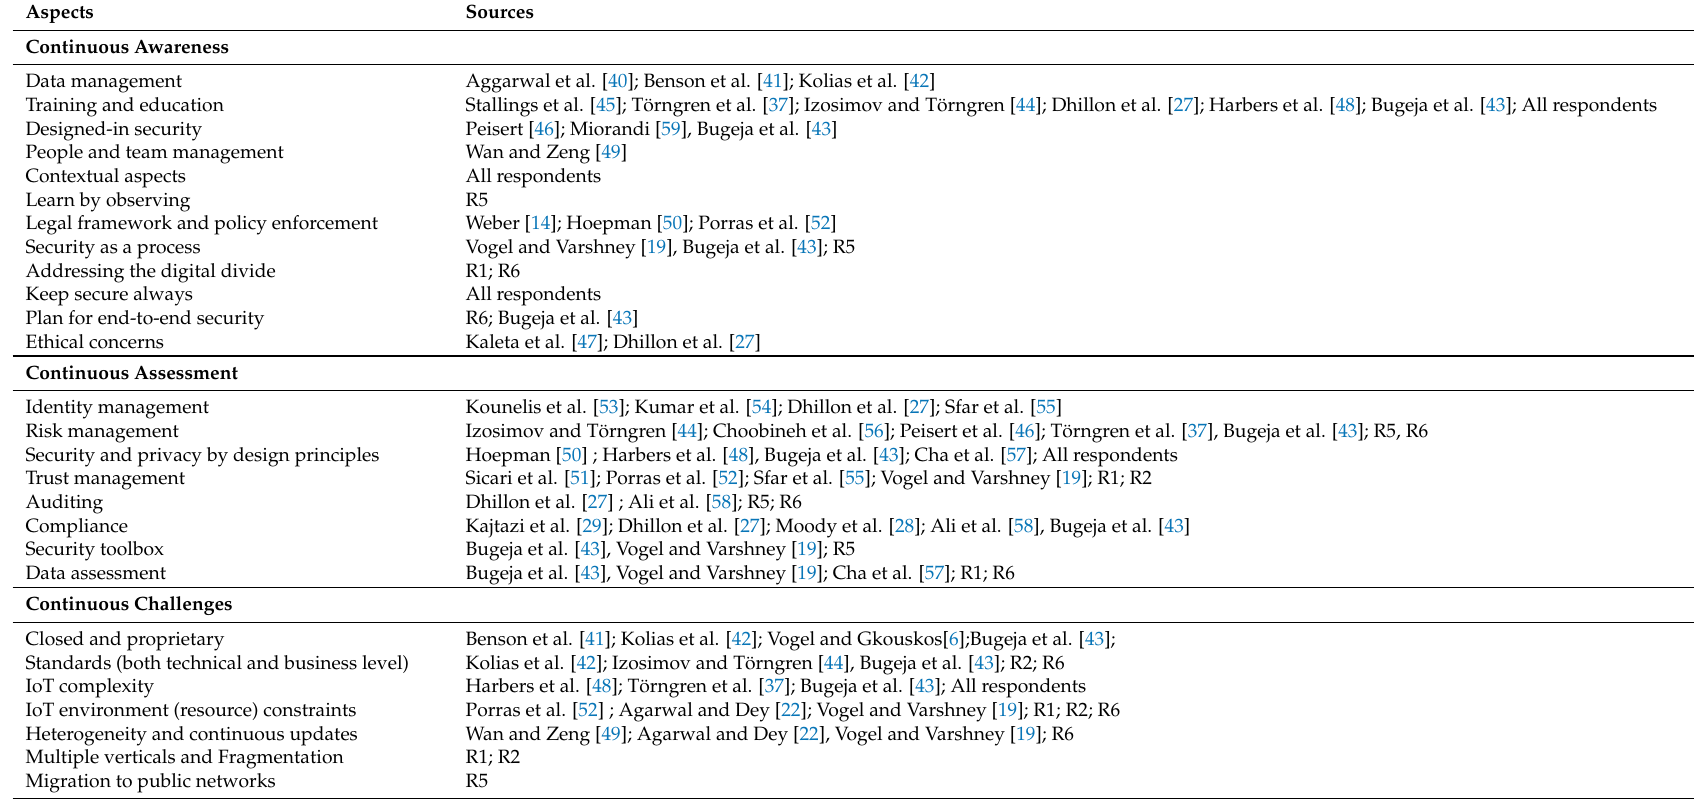
Table 3. Three dimensions and related aspects for IoT Security Thinking